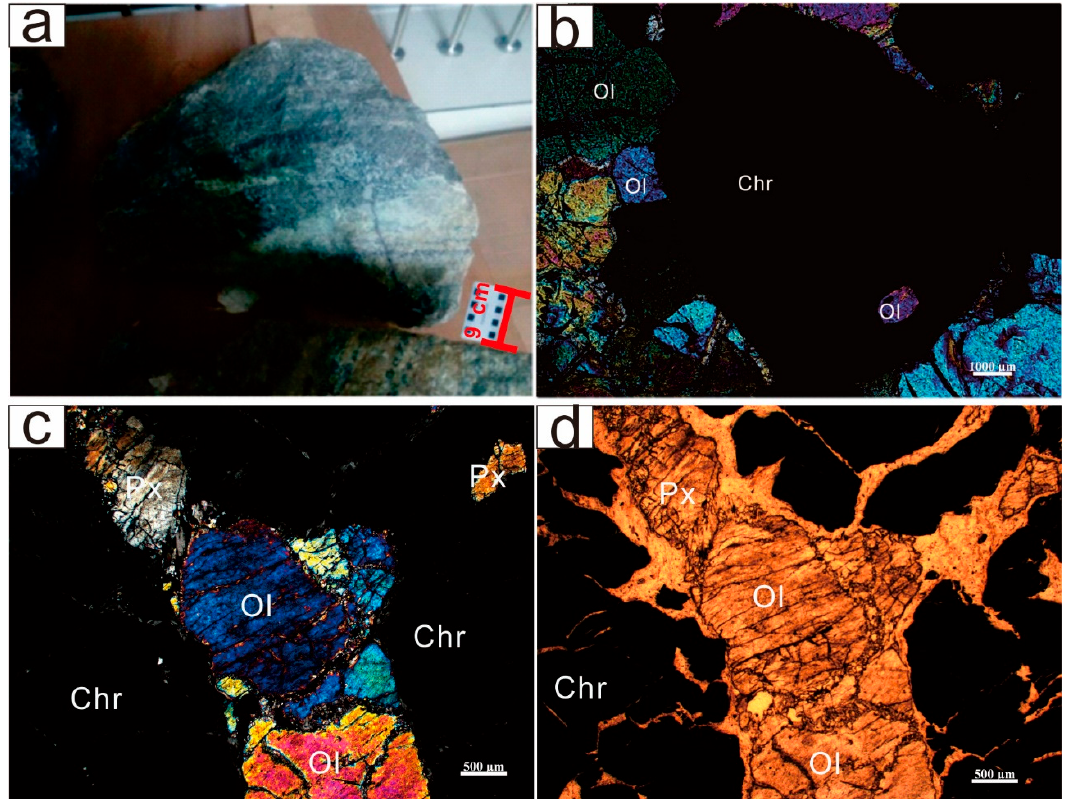
Figure 2. ( a ) Hand specimen of the chromitite, massive, black in color; ( b ) and ( c ) microphotograph in cross-polarized light of the chromitite, euhedral to subhedral chromite; ( d ) microphotograph in transmitted light of ( c ). Abbreviations: Chr = chromite; Ol = olivine; Px = pyroxene.